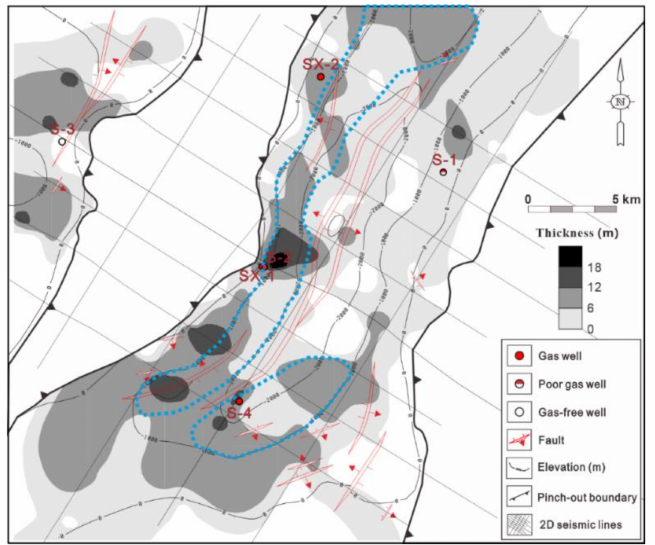
Figure 14. Predicted thickness map of the shale gas reservoirs in Longmaxi